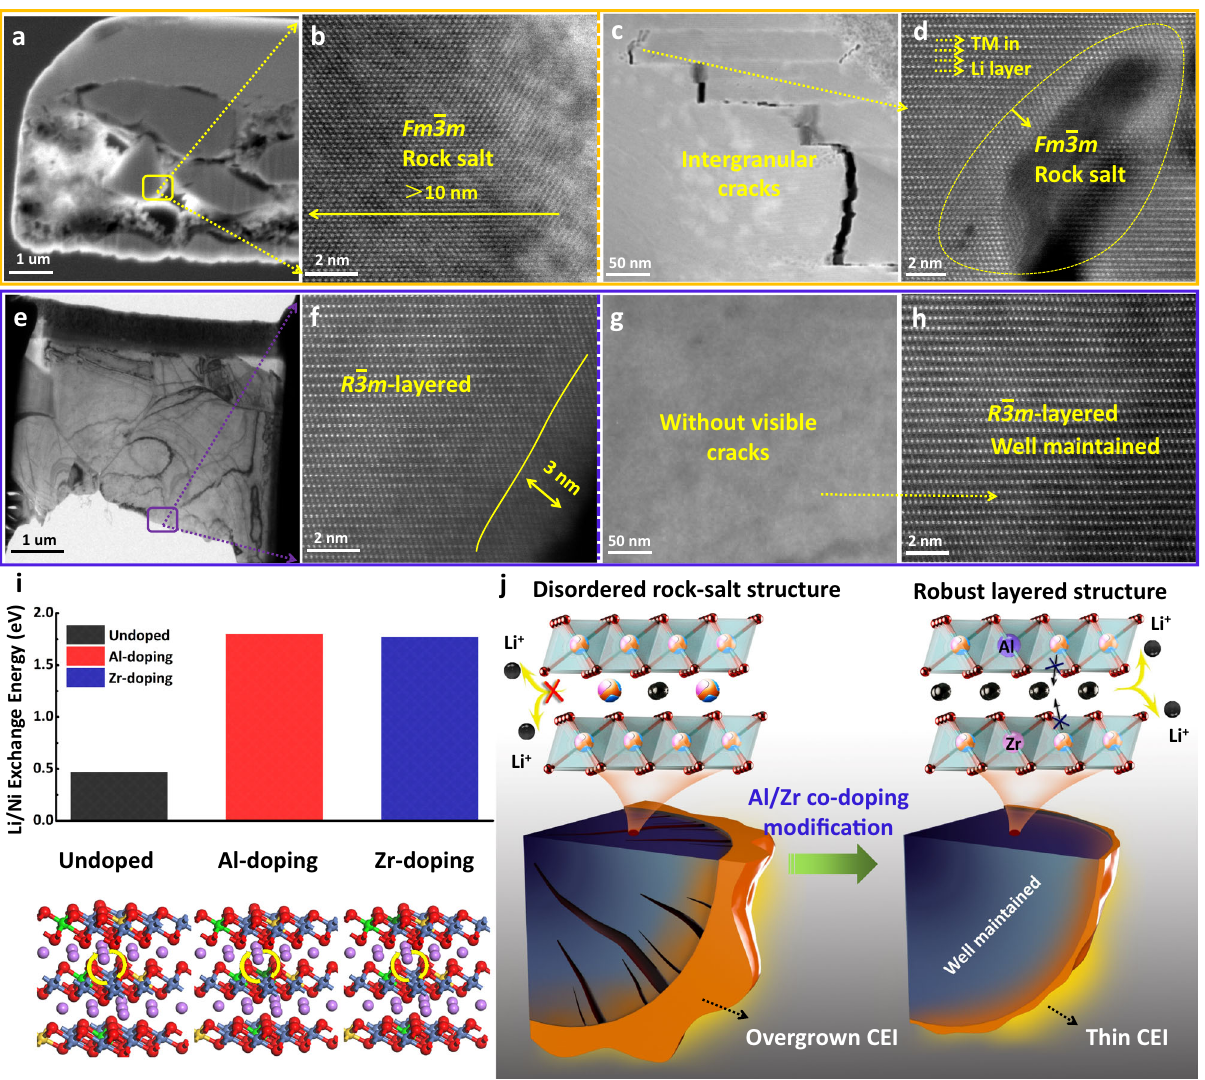
Fig. 7 Morphology and crystal structure of undoped SNCM and AZ0.3-SNCM after 150 cycles at 100 mA g − 1 within 2.75 – 4.6 V. a , b TEM and corresponding HAADF-STEM images of particle surface for undoped SNCM. c , d Cross-sectional TEM and corresponding STEM images of interior region for FIB-prepared undoped SNCM. e , f TEM and corresponding HAADF-STEM images of particle surface for AZ0.3-SNCM. g , h Cross-sectional TEM and corresponding STEM images of interior region for FIB-prepared AZ0.3-SNCM. i Li/Ni exchange energy of undoped SNCM, Al doping and Zr doping SNCM. j Schematic illustration of crack evolution and the internal morphological difference for undoped SNCM and AZ0.3-SNCM electrodes during